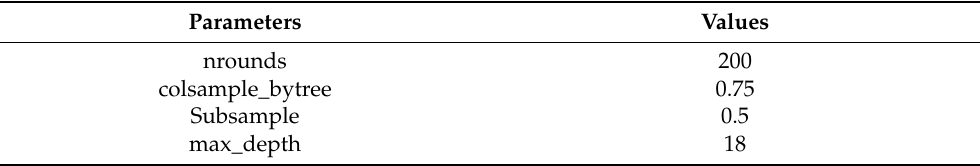
Table 3. XGBoost parameters.